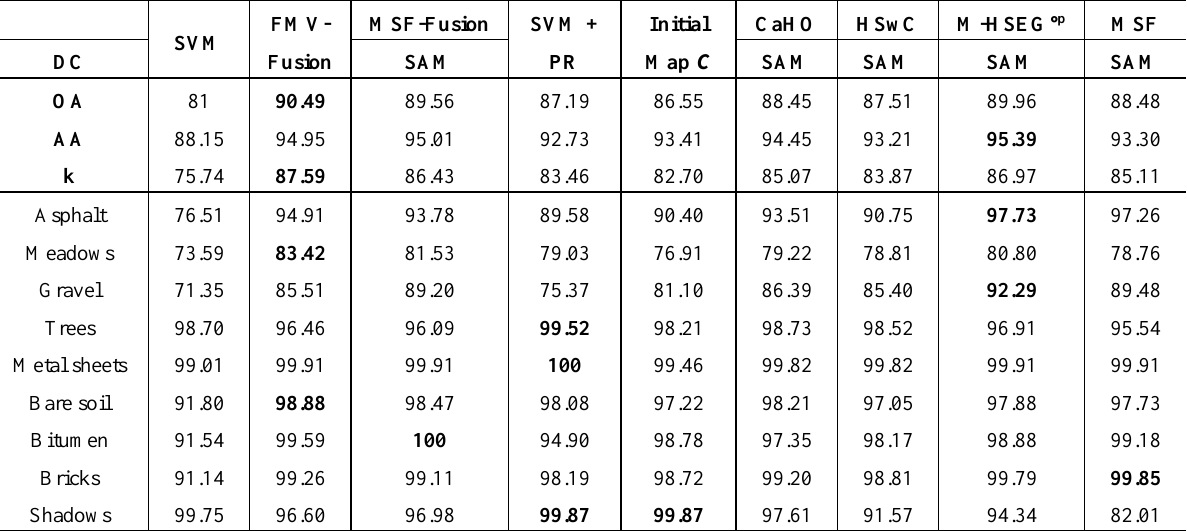
Table 7. Classification accuracies for the University of Pavia